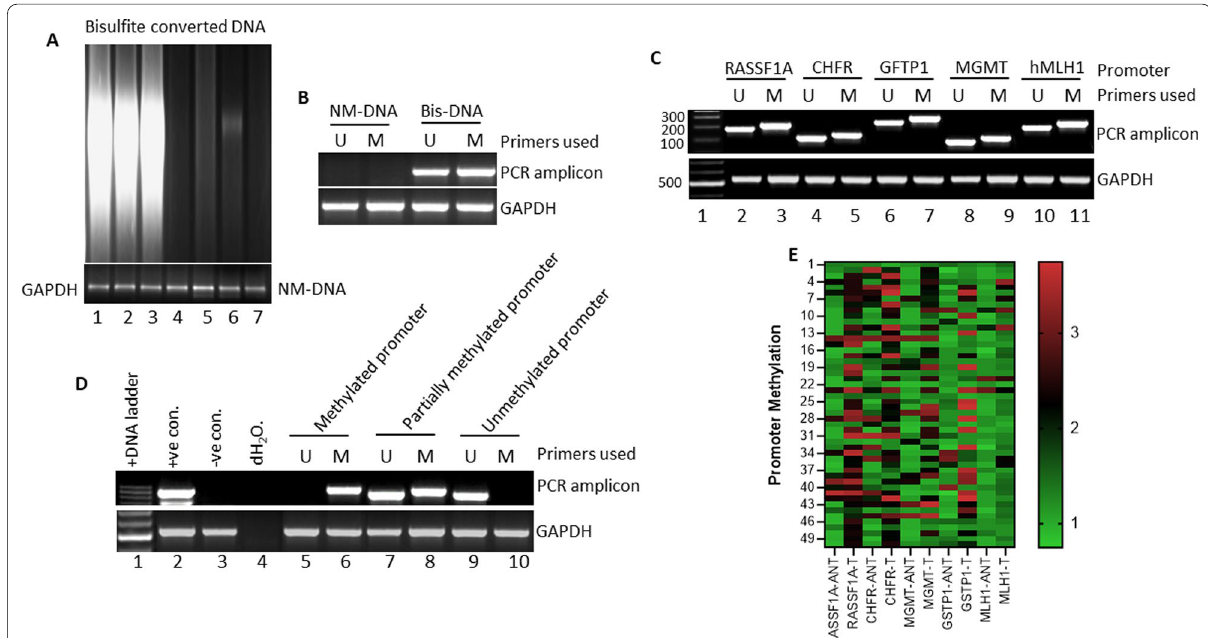
Fig. 2 A DNA integrity after bisulfite conversion: Pre‑amplification visualization on agarose gel electrophoresis. Two µl of the eluted bisulfite‑converted DNA was loaded and run on 2% gel in TBS buffer for 60 min. Smears with equal intensities indicate the presence of the converted DNA. Lanes (1–3) good conversion, lanes (5 and 6) weak conversion, and lanes (4 and 7) no conversion. B The specificity of the primers. Bisulfite Modified (BM‑DNA) and Unmodified DNA (UM‑DNA) were amplified with primers specific for unmethylated (U) and methylated (M) DNA. Only modified DNA showed PCR amplicons. GAPDH of the UM‑DNA used as a control for equal loading. C Localization of methylated and unmethylated PCR band of every TSG. Ethidium bromide‑stained agarose gel electrophoresis of bisulfite modified DNA amplified with primers specific for unmethylated (U) and methylated (M) DNA. Lane 1 100 bp molecular marker, lane 2–3 PCR amplicons of RASSF1A promoter detected at 203 bp, lane 4‑5 PCR amplicons of CHFR promoter at 144 bp, lane 6‑7 PCR amplicons of GSTP1 promoter at 159 bp, lane 8‑9 PCR amplicons